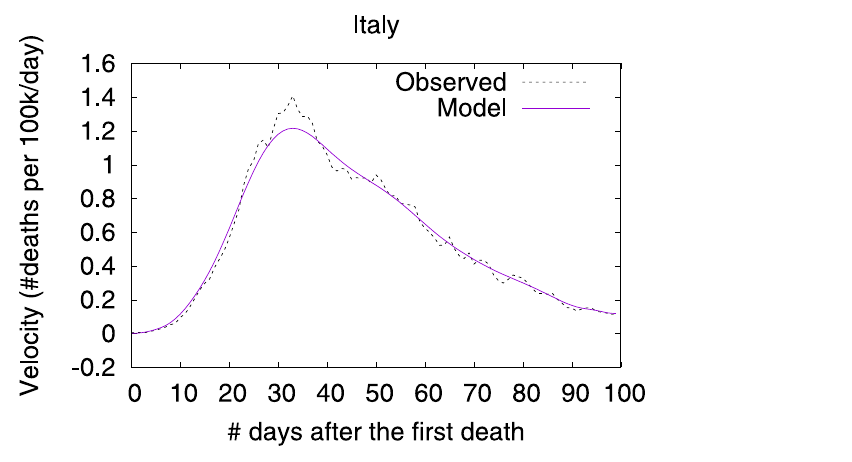
Fig 7. (Color online) projections for velocity in